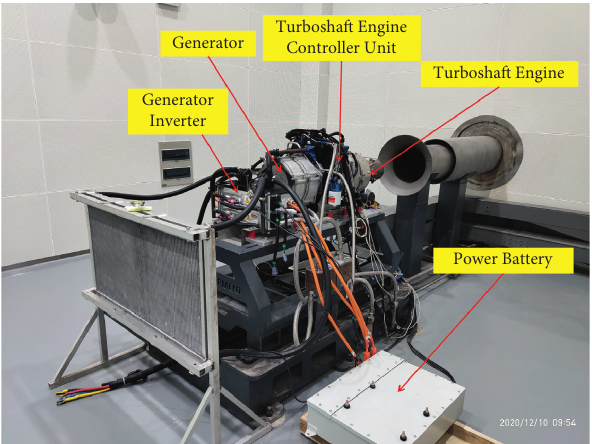
Figure 2: Configuration of